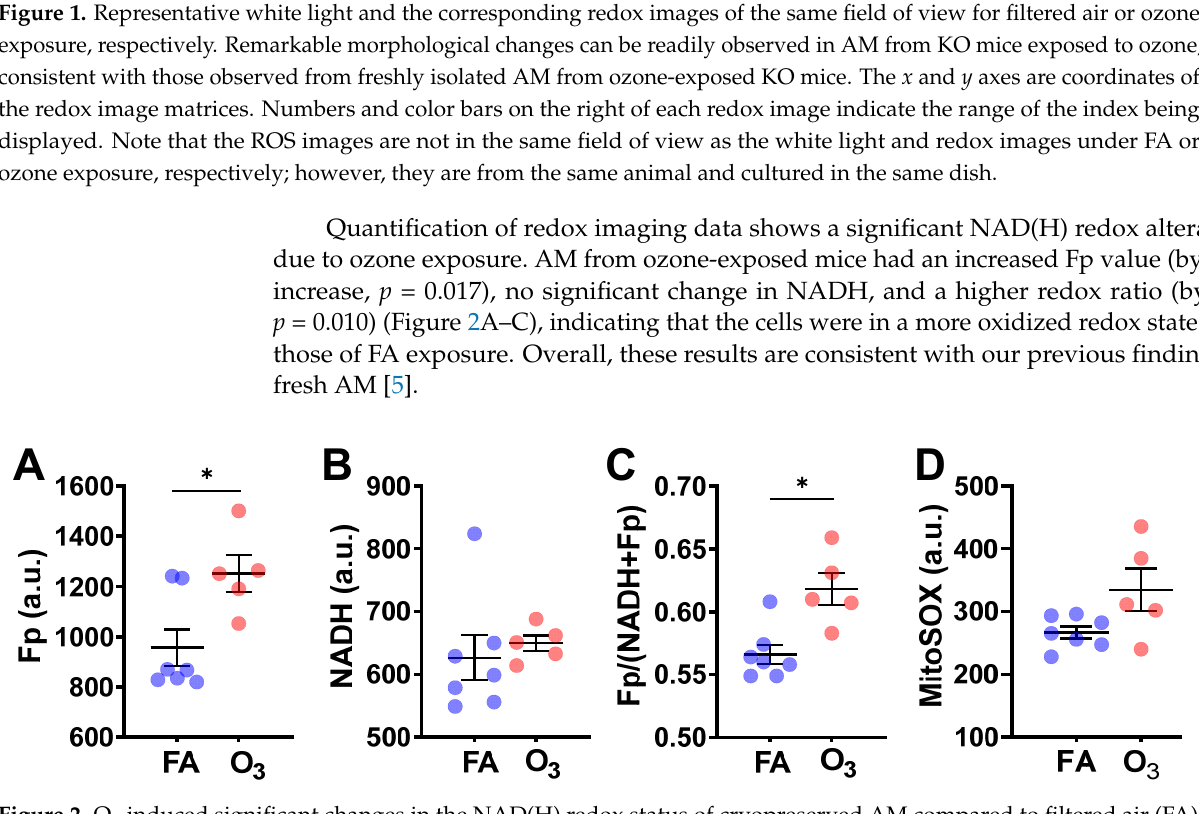
Figure 2. O 3 induced significant changes in the NAD(H) redox status of cryopreserved AM compared to filtered air (FA). Each dot represents an AM sample from one mouse. ( A ) Significant increase in Fp; ( B ) no significant changes in NADH; ( C ) significant increase in the redox ratio; ( D ) no significant difference in mitochondrial ROS level despite a trend of increase induced by O 3 (data shown as mean ± SD). * p < 0.05.